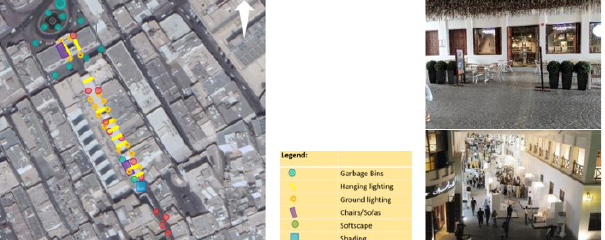
Figure 16. Services distributions according to users’ needs (Researcher).